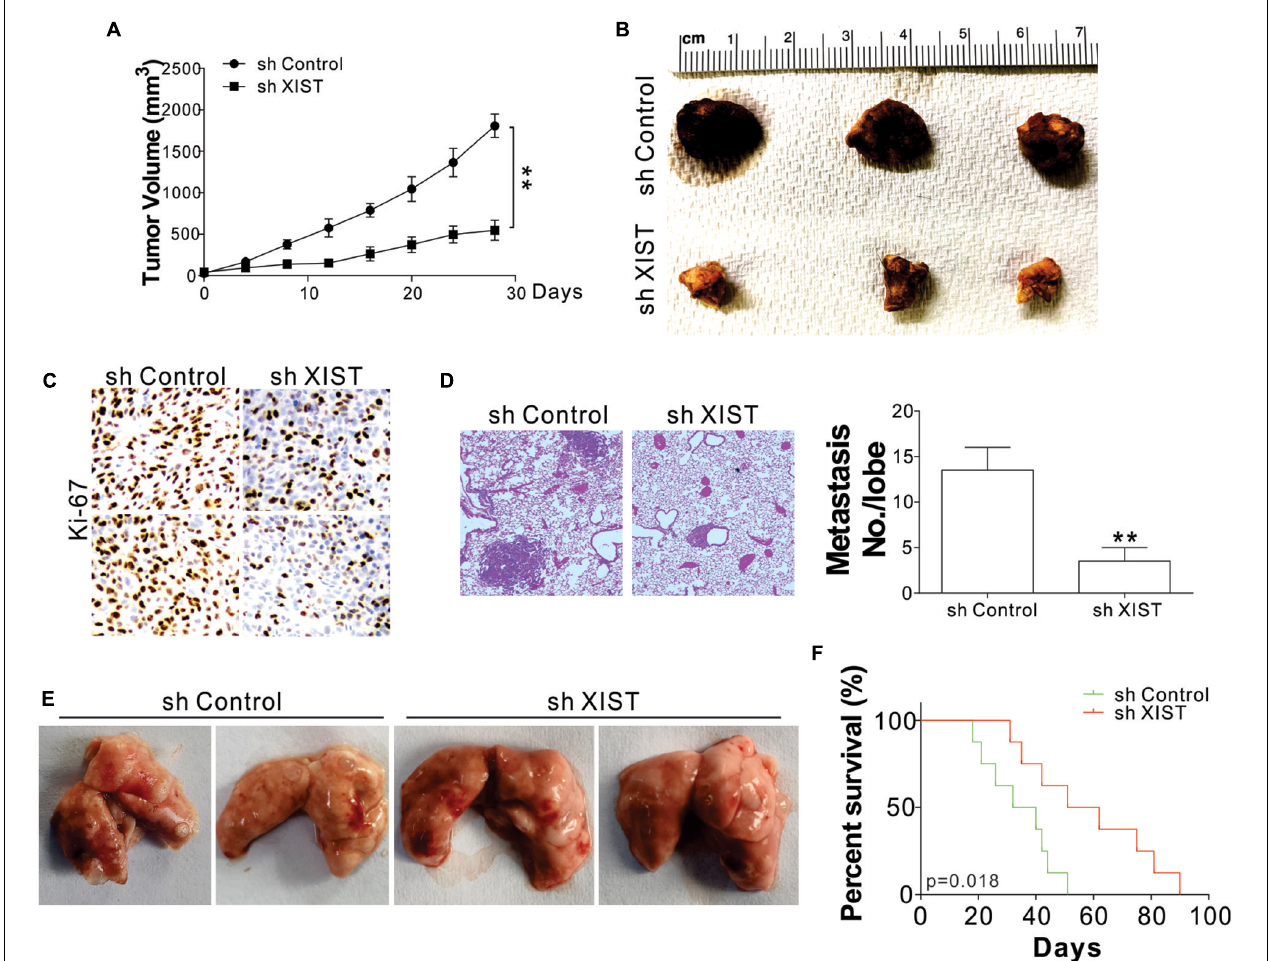
FIGURE 3 | Depletion of XIST suppressed SNK-6 xenograft growth and metastasis. (A) The tumor growth in nude mice xenografted with SNK-6 stably transfected with a control or XIST shRNA ( n = 6). (B) Representative tumors. (C) Representative Ki-67 staining in different tumor groups. (D) The H&E staining and metastatic number in the lung of nude mice injected with SNK-6 stably transfected with a control or XIST shRNA via tail vein at 5 weeks. (E) Representative pictures of lung tumors in different groups of mice ( n = 6). (F) The survival of nude mice injected with SNK-6 stably transfected with a control or XIST shRNA via tail vein ( n = 8). ** p <